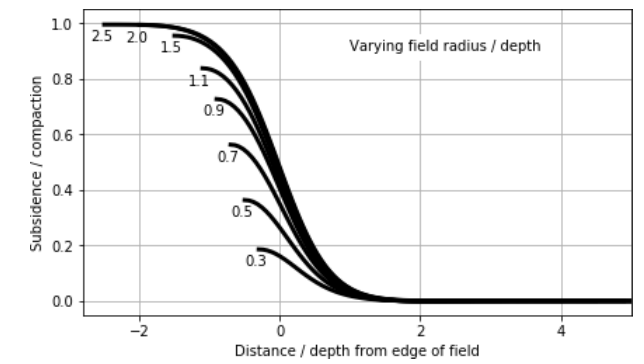
Figure 4. As Fig. 3, but for a steeper bowl form factor. Due to the now smaller surface expression of a point source, fields larger than twice the depth will see the full compaction as subsidence.